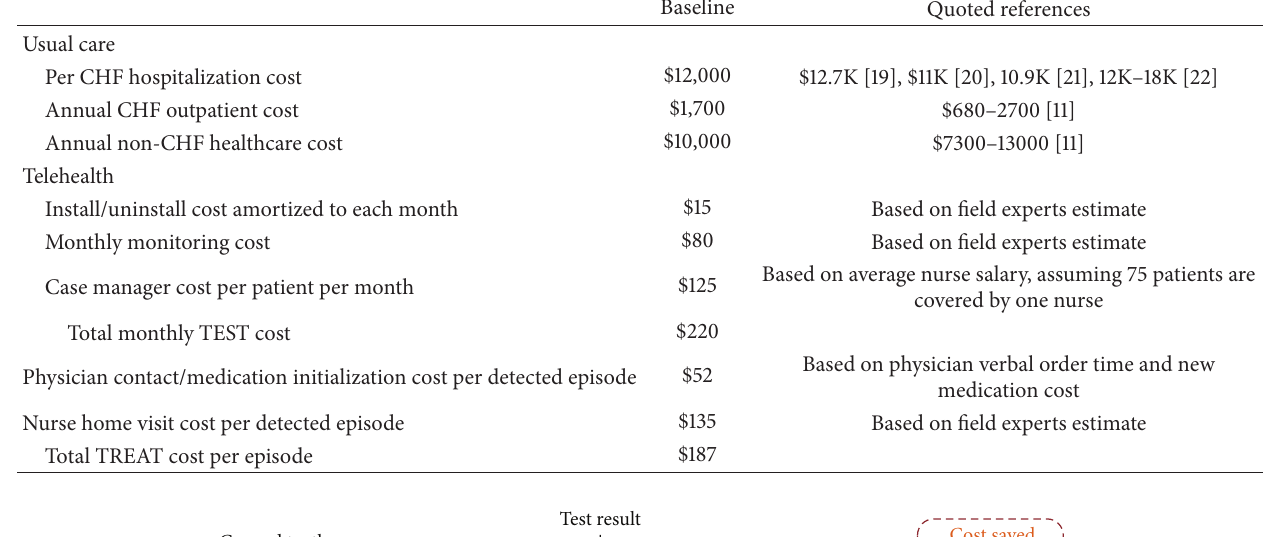
Table 3: Cost estimates.